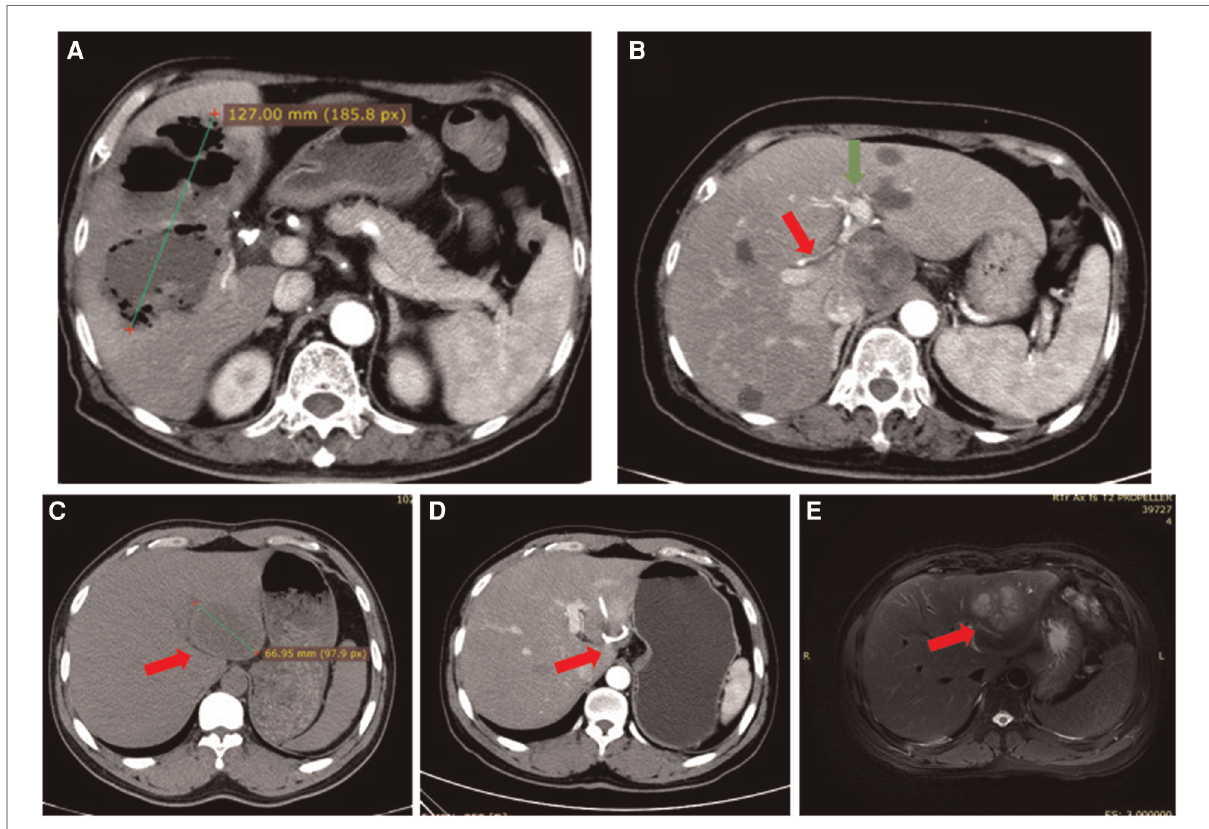
FIGURE 1 ( A ) case #1. Irregular low-density shadows were observed in the liver with clear boundaries and uneven internal density. Scattered gas density shadows were observed, and some gas-liquid planes were observed with a large cross section of approximately 127 mm. ( B ) Case #2. Image showing the lack of a space to place a drainage tube; The red arrow points to the right hepatic artery, The green arrow points to the left hepatic artery. ( C ) Case #3. The left lobe of the liver is a round low-density focus, approximately 53 mm in size. ( D ) Case #3. A drainage duct shadow was seen in the left lobe of the liver, with a few adjacent patchy low-density shadows. ( E ) Case #3. Recurrent abscess after treatment of liver abscess: A multilocular cystic solid long T2 signal shadow was seen in the left lobe of the liver, the maximum cross-section was 66 mm, and the boundaries were blurred. Left lobe lesion of the liver, abscess